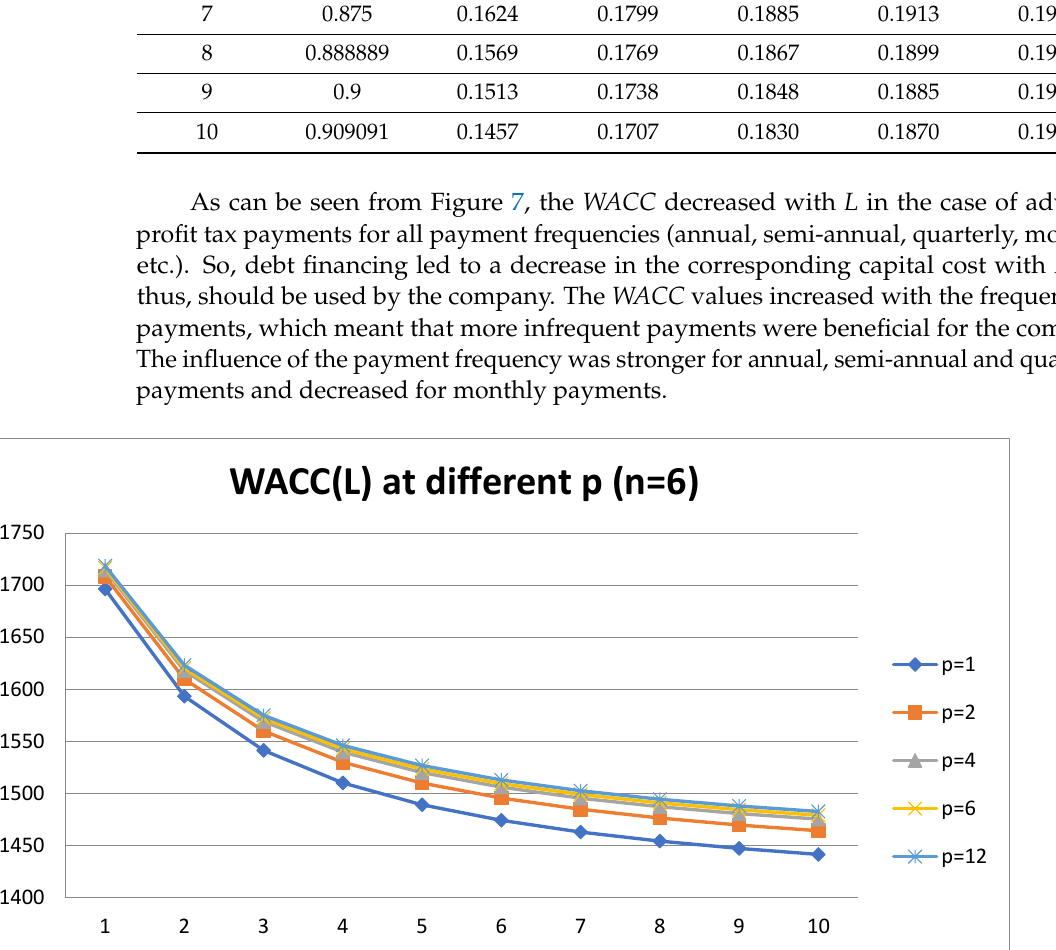
Figure 7. The dependence of the WACC on the leverage level ( L ) of a six-year-old company for advance profit tax payments with frequencies of p = 1, 2, 4, 6 and 12.